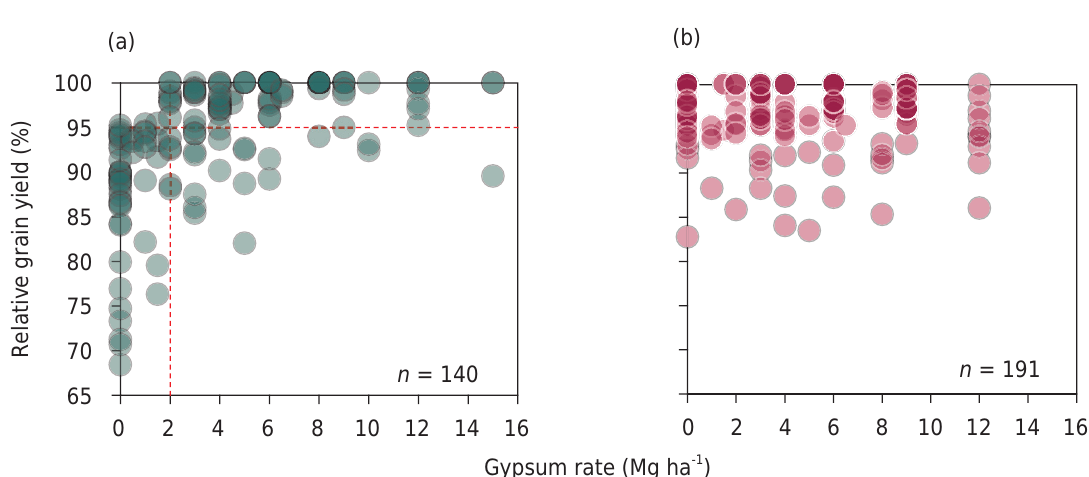
Figure 4. Relative grain yield for growing seasons with positive response (a) and no response (no statistical difference) (b) to gypsum application to subtropical soils under no-tillage in Southern Brazil. Graphs constructed from data in table 1.